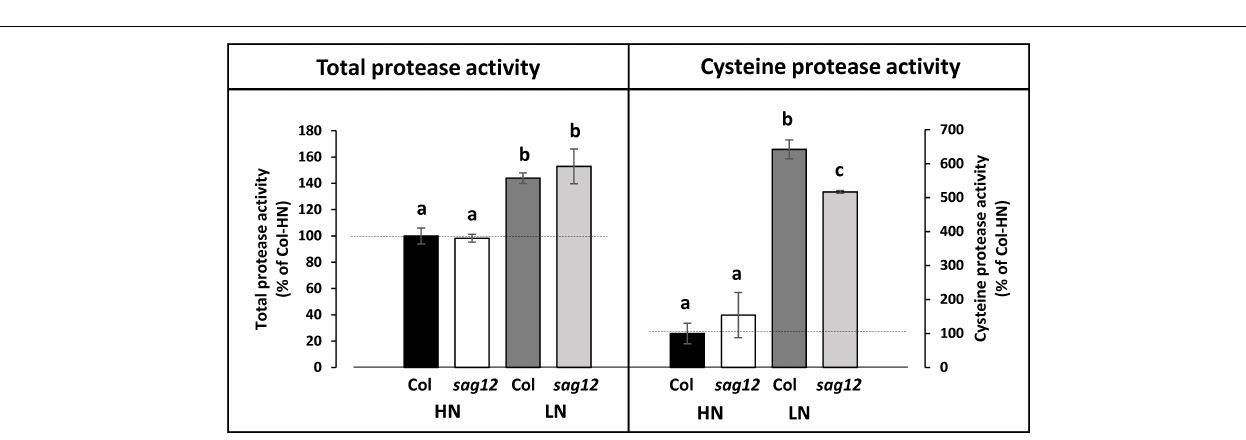
FIGURE 6 | SAG12 is expressed in the root vascular tissues. The tissues where the SAG12 promoter was active were identified using the promoterSAG12::UIDA lines and GUS staining. Roots were observed using a light microscope. Transgenic lines were cultivated under HN (A,C) and LN (B,D,E) conditions and harvested at the reproductive stage. Representative pictures of the results obtained for whole root (A,B) and transverse root sections (C,D) are shown. Root section under UV excitation (E) . Xy, xylem tissue.